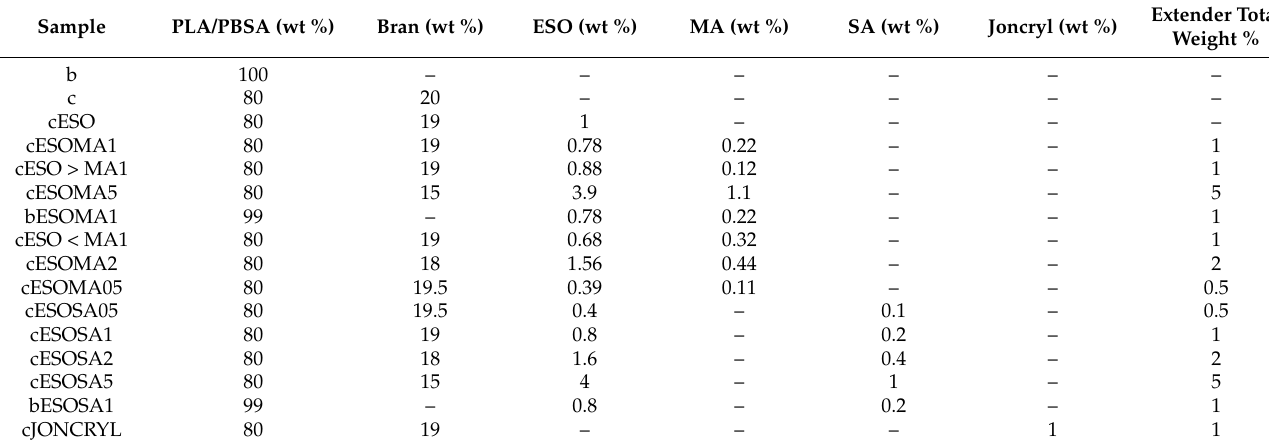
Table 1. Weight compositions of prepared